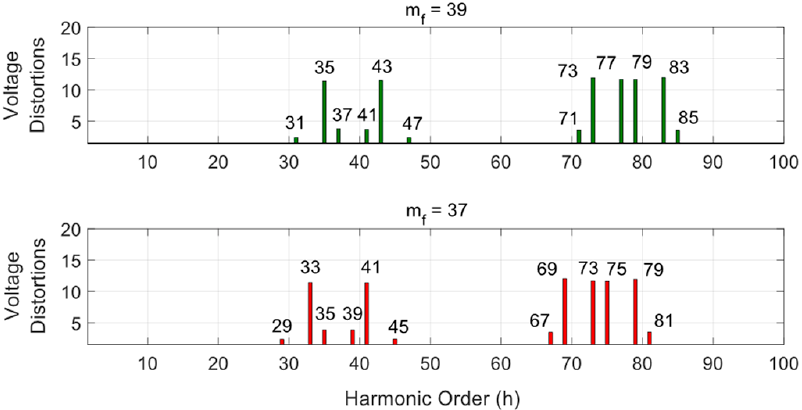
Figure 22. Voltage spectra (in percentage) of a three-level NPC converter operated with SPWM for two frequency–modulation indices.